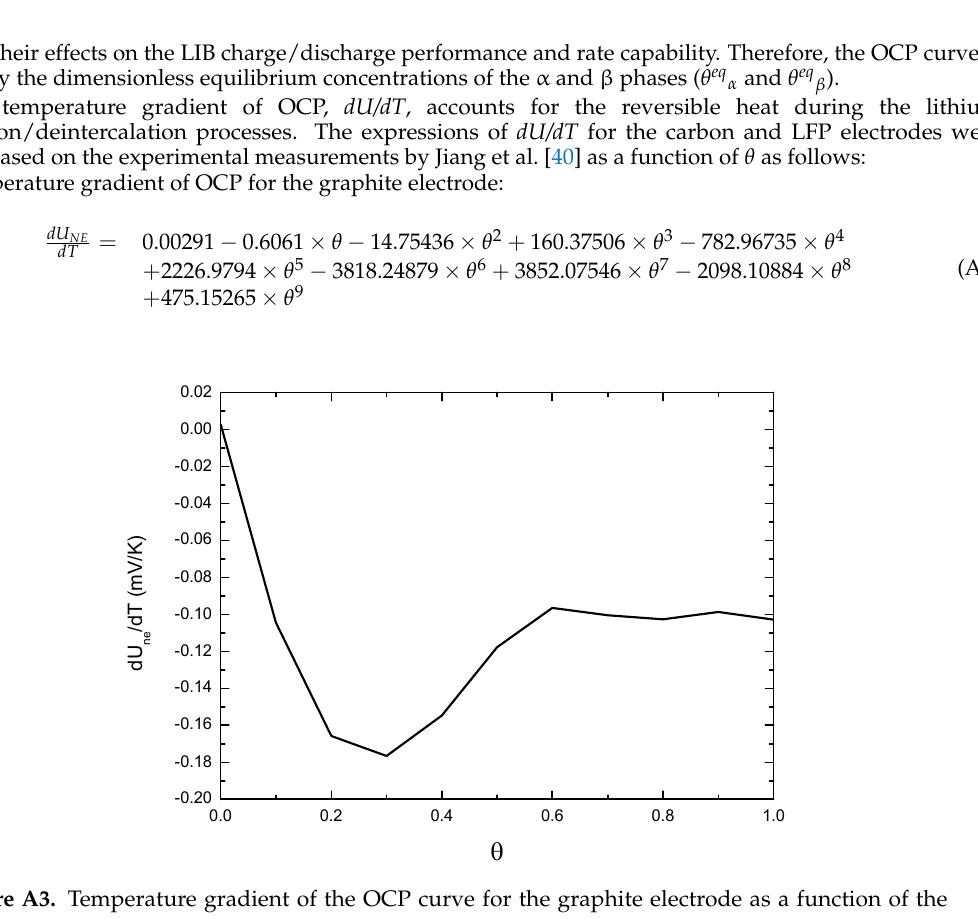
Figure A3. Temperature gradient of the OCP curve for the graphite electrode as a function of the dimensionless lithium content, θ .